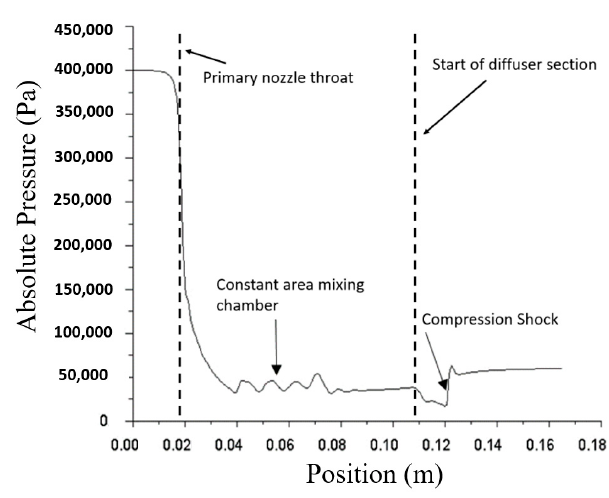
Figure 8. CFD data extraction for pressure at the axis for ejector model. For validation of the CFD model, an ejector design with geometric parameters re- ported by Huang et al. [34] has been used with the same working fluid and working con- ditions. For the purpose of validation, Figure 9 gives the comparison of CFD results with various other published works that are using the same geometer and conditions. The solid line is showing the exact match between simulation and experiments, and the points nearer to the line indicate good agreement. For our CFD results, the percentage difference is found to be 3.3%.